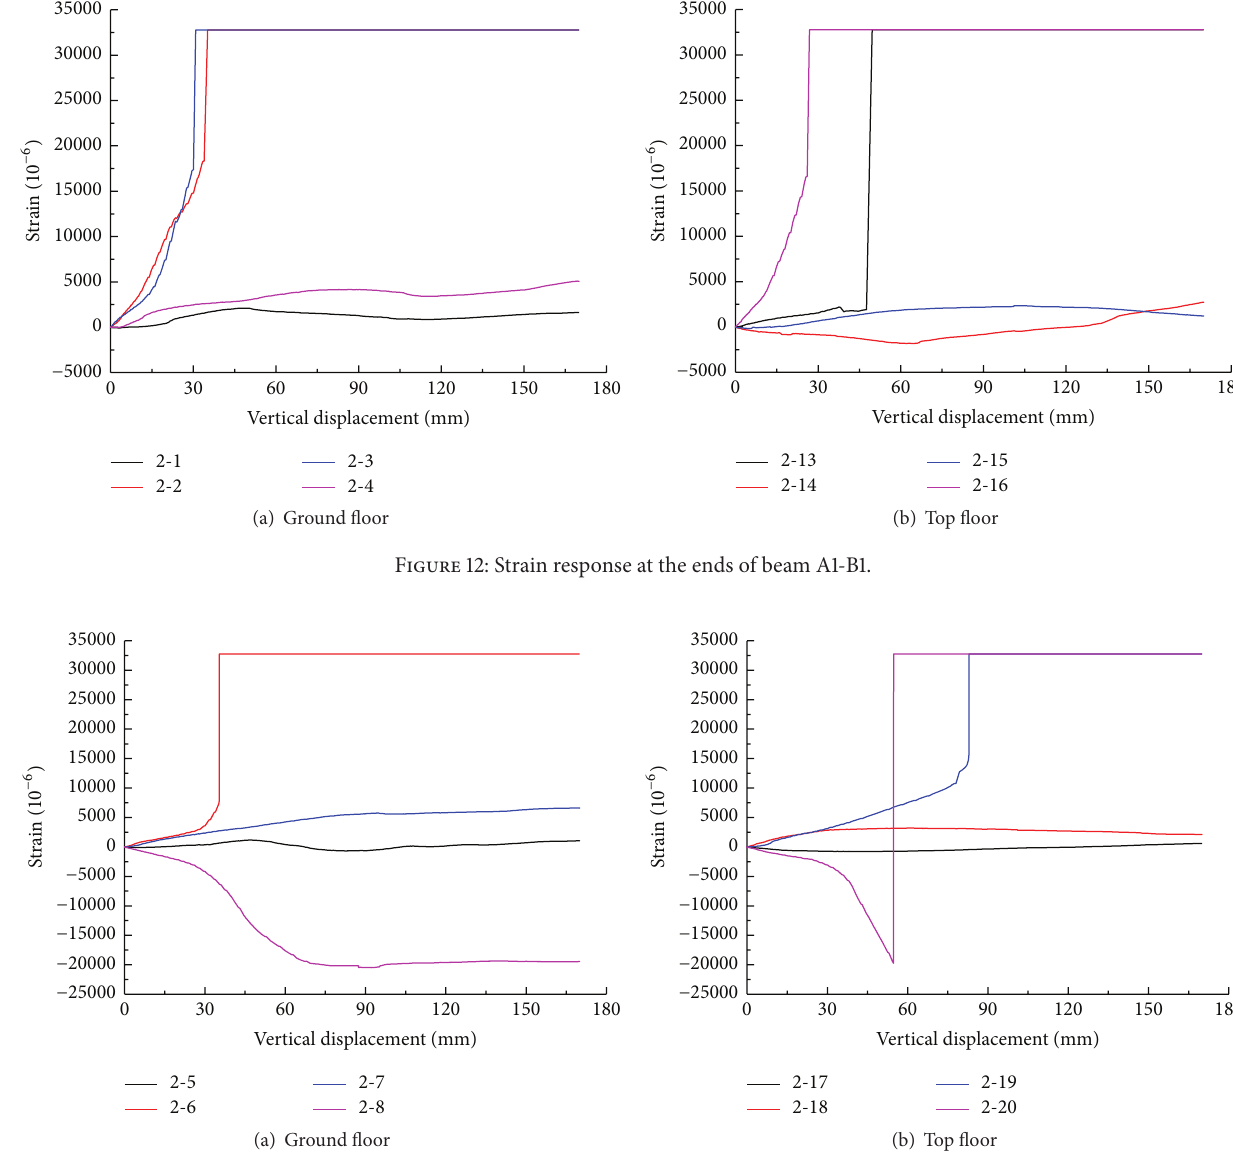
Figure 13: Strain response at the ends of beam